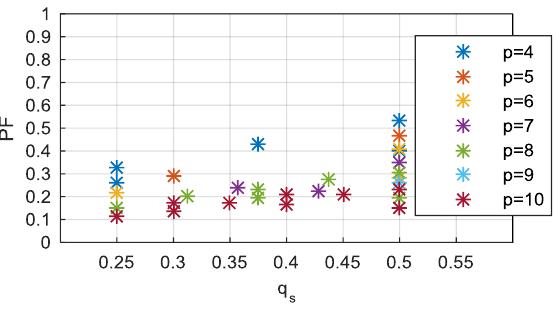
Figure 20. Power factor ( PF ) versus stator slot number per pole and phase ( q s ) for FSCW machines.